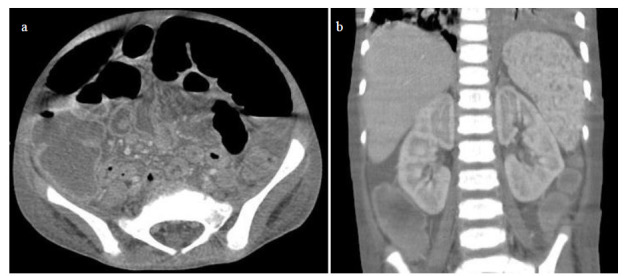
 Abdominopelvic spiral computed tomography scan with contrast (with coronal reconstruction)
(Multiple axial and coronal images through the abdomen and pelvis after intravenous and oral
administration of the contrast demonstrates that diffuse bowel dilatation associated with
fluid-filled loops were present down to the distal sigmoid part, in addition to the thickened bowel walls [a].
The liver has a normal homogeneous density with the evidence of periportal edema. In contrast,
multiple small splenic lesions [low-density nodular patterns] in addition to inhomogeneous density are observed in the spleen [b]).